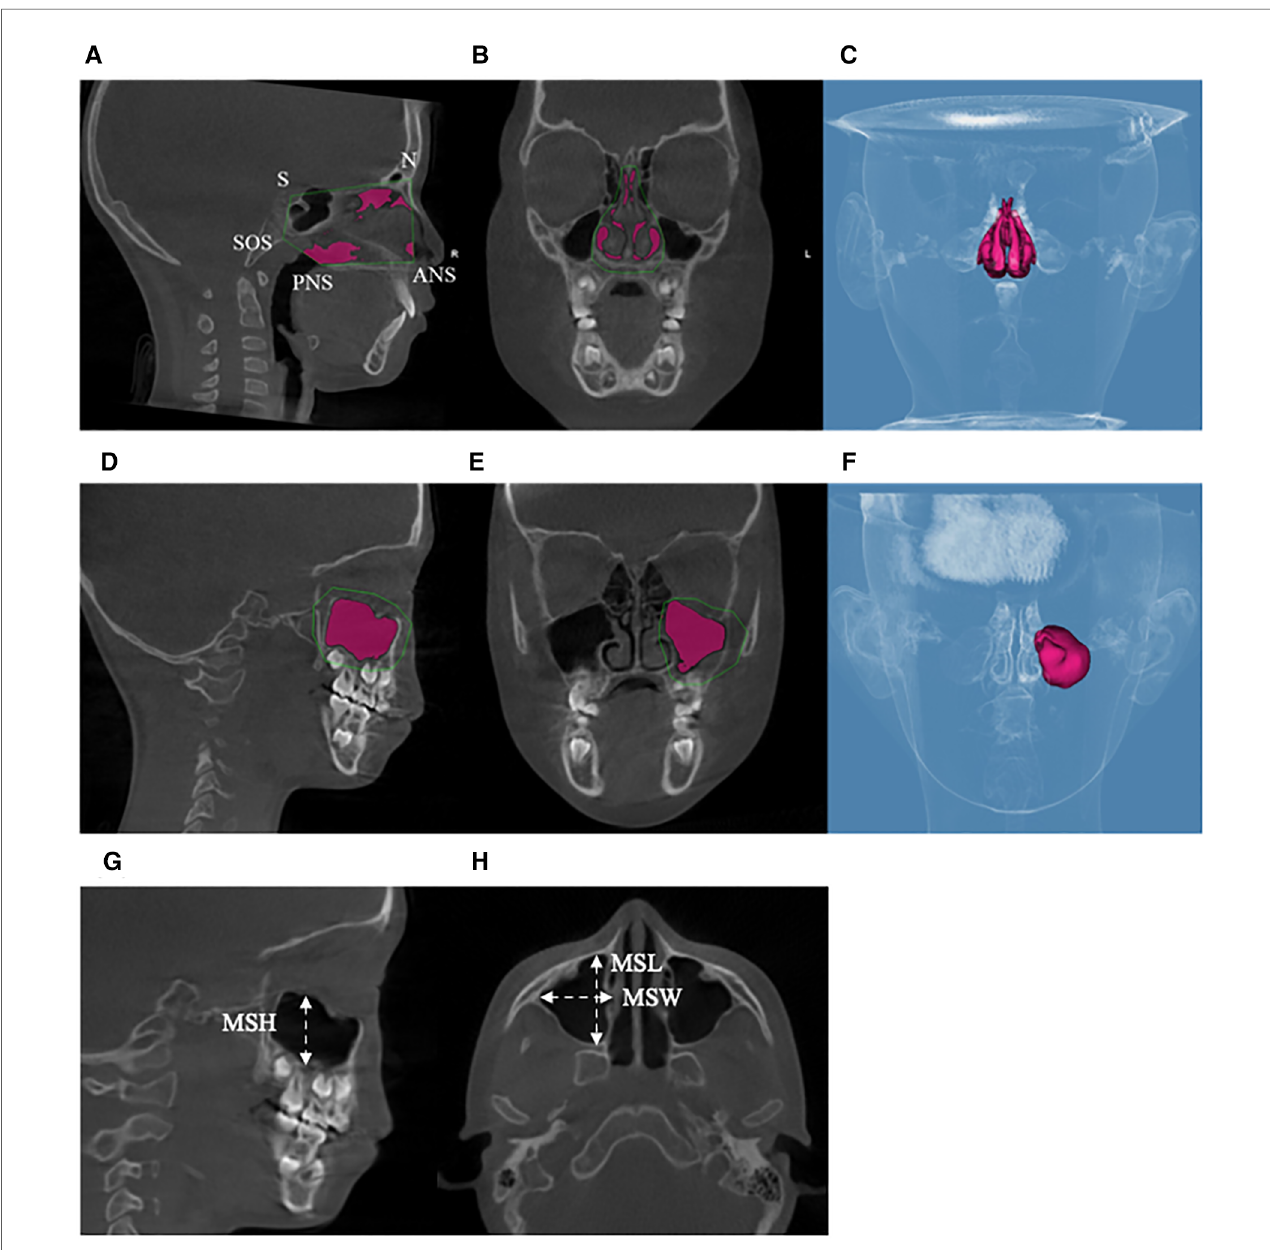
FIGURE 5 Measurements of the maxillary sinus and nasal cavity. ( A – C ) Maxillary sinus boundaries and maxillary sinus volume. ( D – F ) Nasal cavity boundaries and nasal cavity volume. ( G ) The height of the maxillary sinus. ( H ) The width of the maxillary sinus and the length of the maxillary